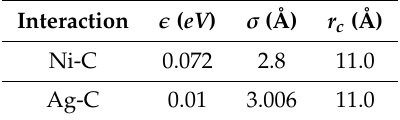
Table 2. Lennard-Jones parameters for Ni-C and